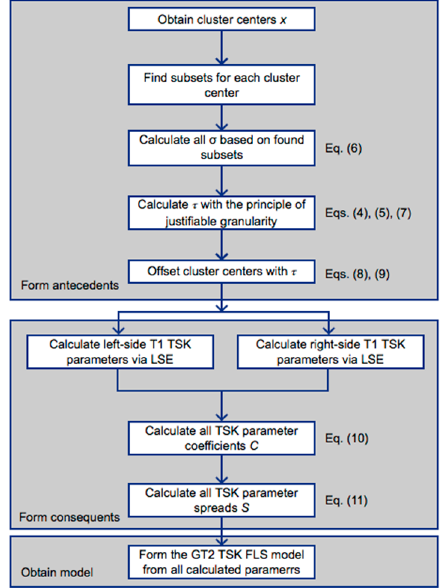
Figure 6. General schematic of the sequence taken by the proposed hybrid algorithm, such that antecedents are calculated first, and consequents afterwards.